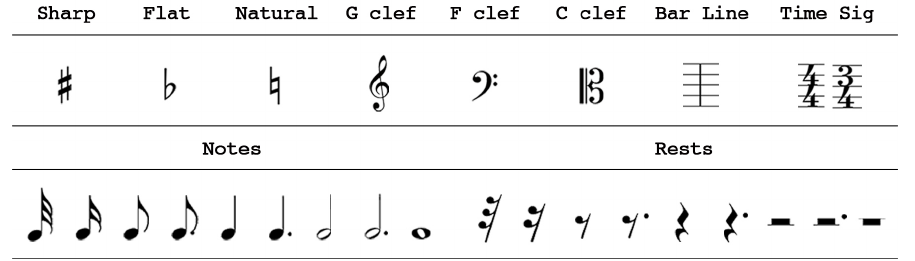
Figure 2. The classes of symbols from MuseScore used in our work. These symbols are depicted without considering their pitch and duration.